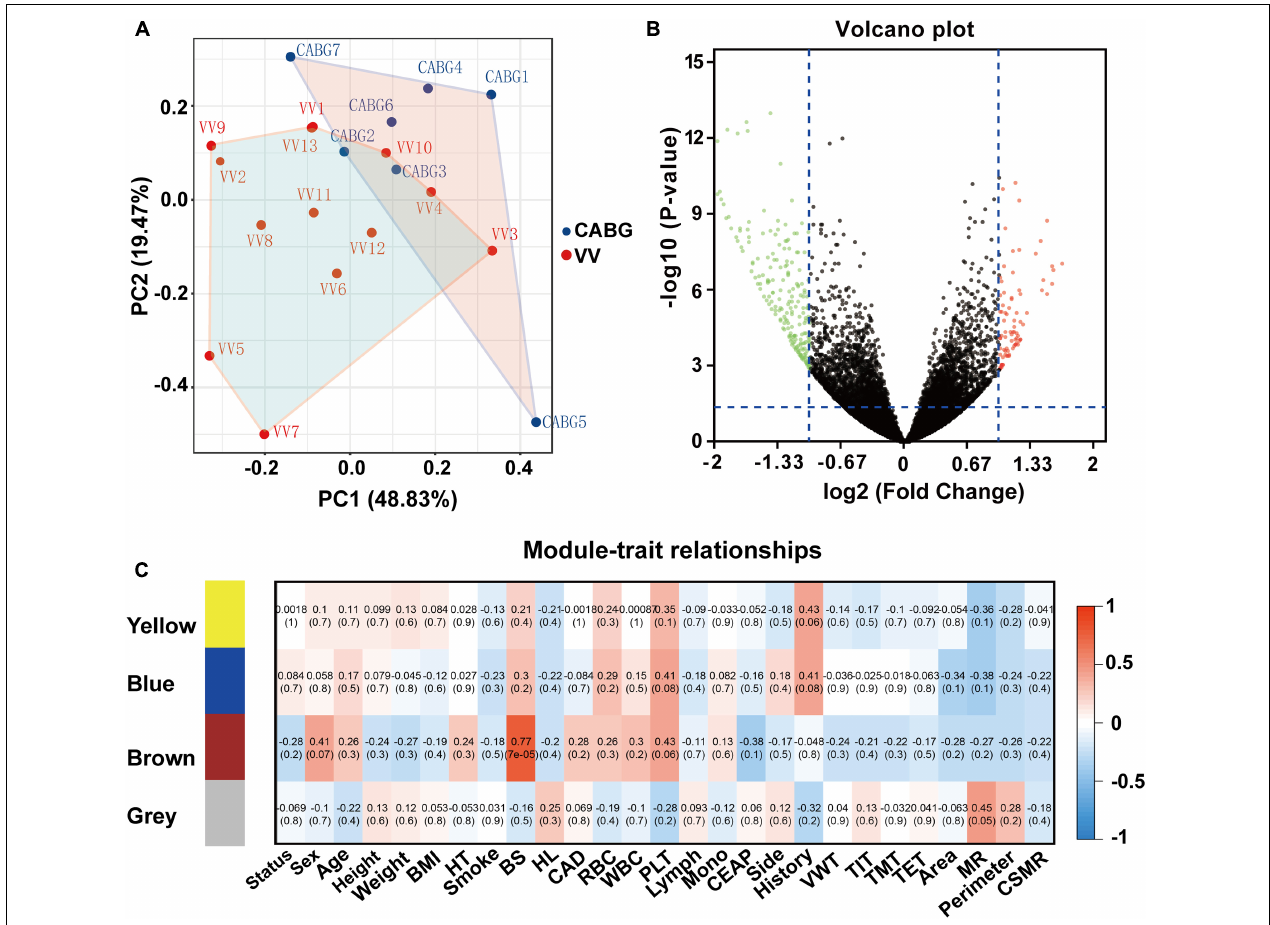
FIGURE 1 | Differentially expressed genes (DEGs) analysis of varicose veins (VV) and great saphenous veins (GSV) from coronary artery bypass grafting (CAGB) patients. (A) PCA plot of all the samples. The VV group and CABG group show distinct separation. (B) Volcano plot of differentially expressed genes of VV vs. CABG. Green dots indicate downregulated genes, red dots indicate upregulated genes, and black dots indicate non-significance with cut-off criteria ( P -value < 0.05, abs (log2FC) > 1). (C) DEGs were divided into four module genes with WGCNA analysis. The heatmap visualization of correlation between module genes and samples